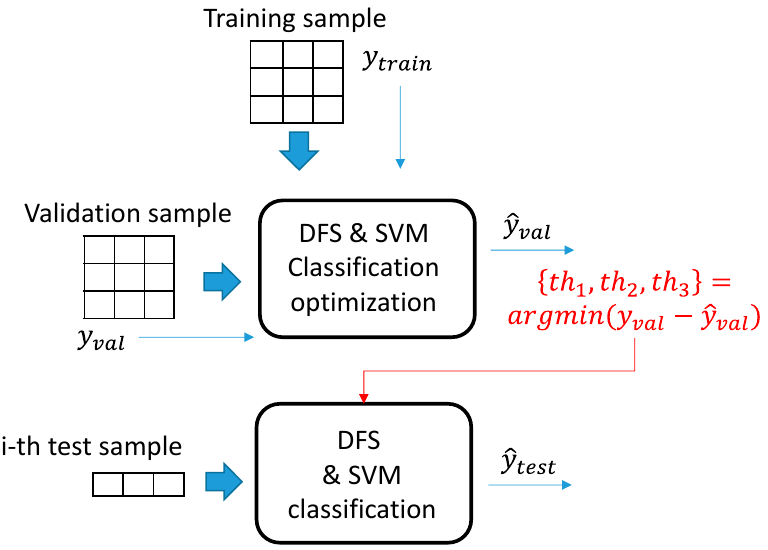
Figure 3. A schematic representation of the procedure for DFS assessment over the MSI dataset.